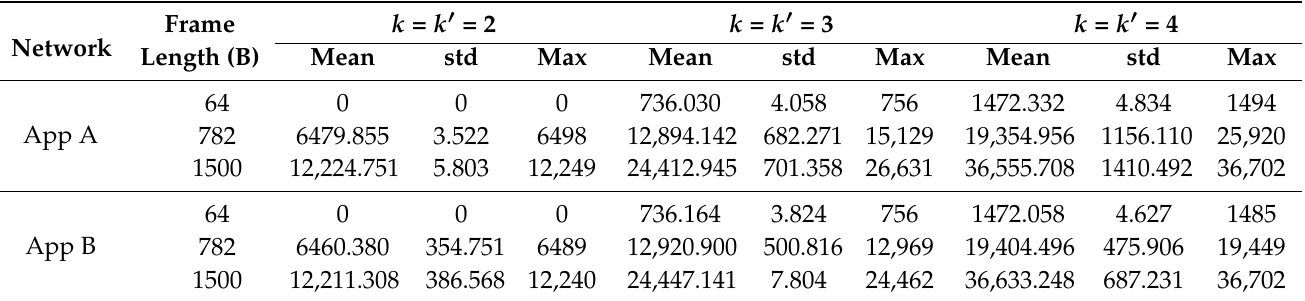
Table 4. Mean, standard deviation and maximum jitter when transmitting two, three and four replicas using approach A and approach B in a one-hop network. All the results are in nanoseconds.